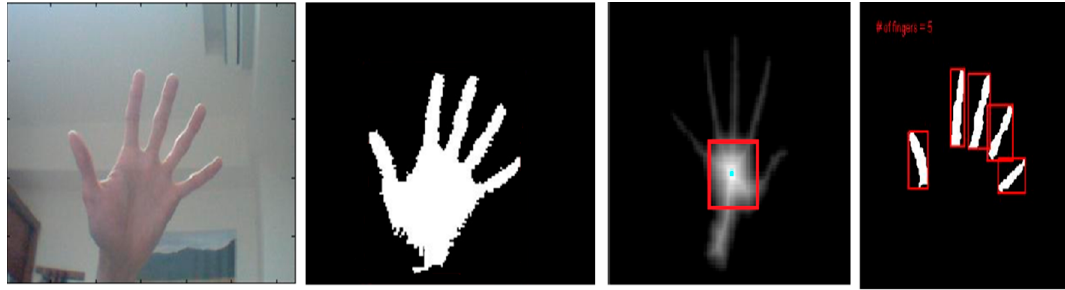
Figure 11. The image processing results.